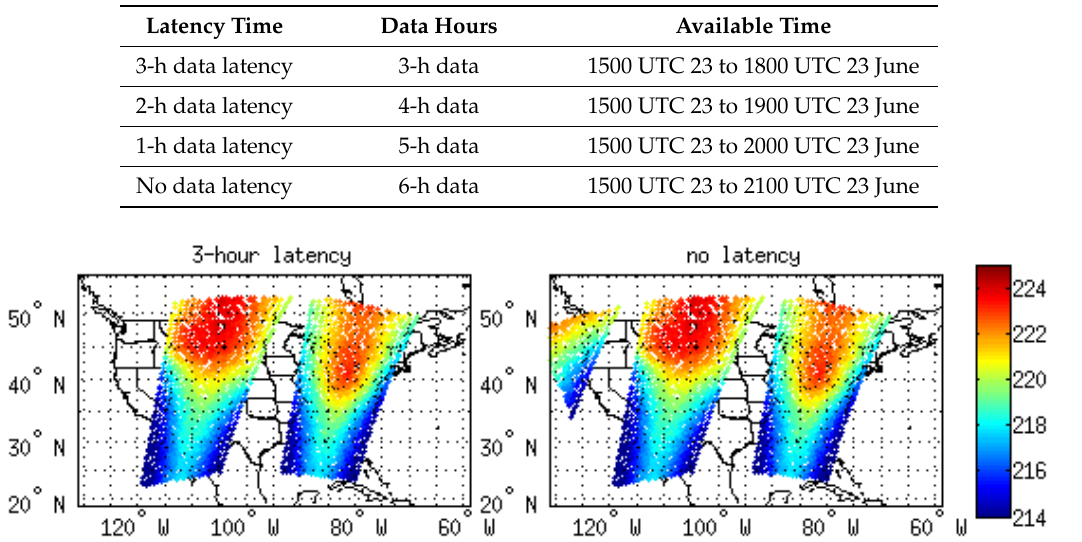
Table 1. The available data hours and data latency.